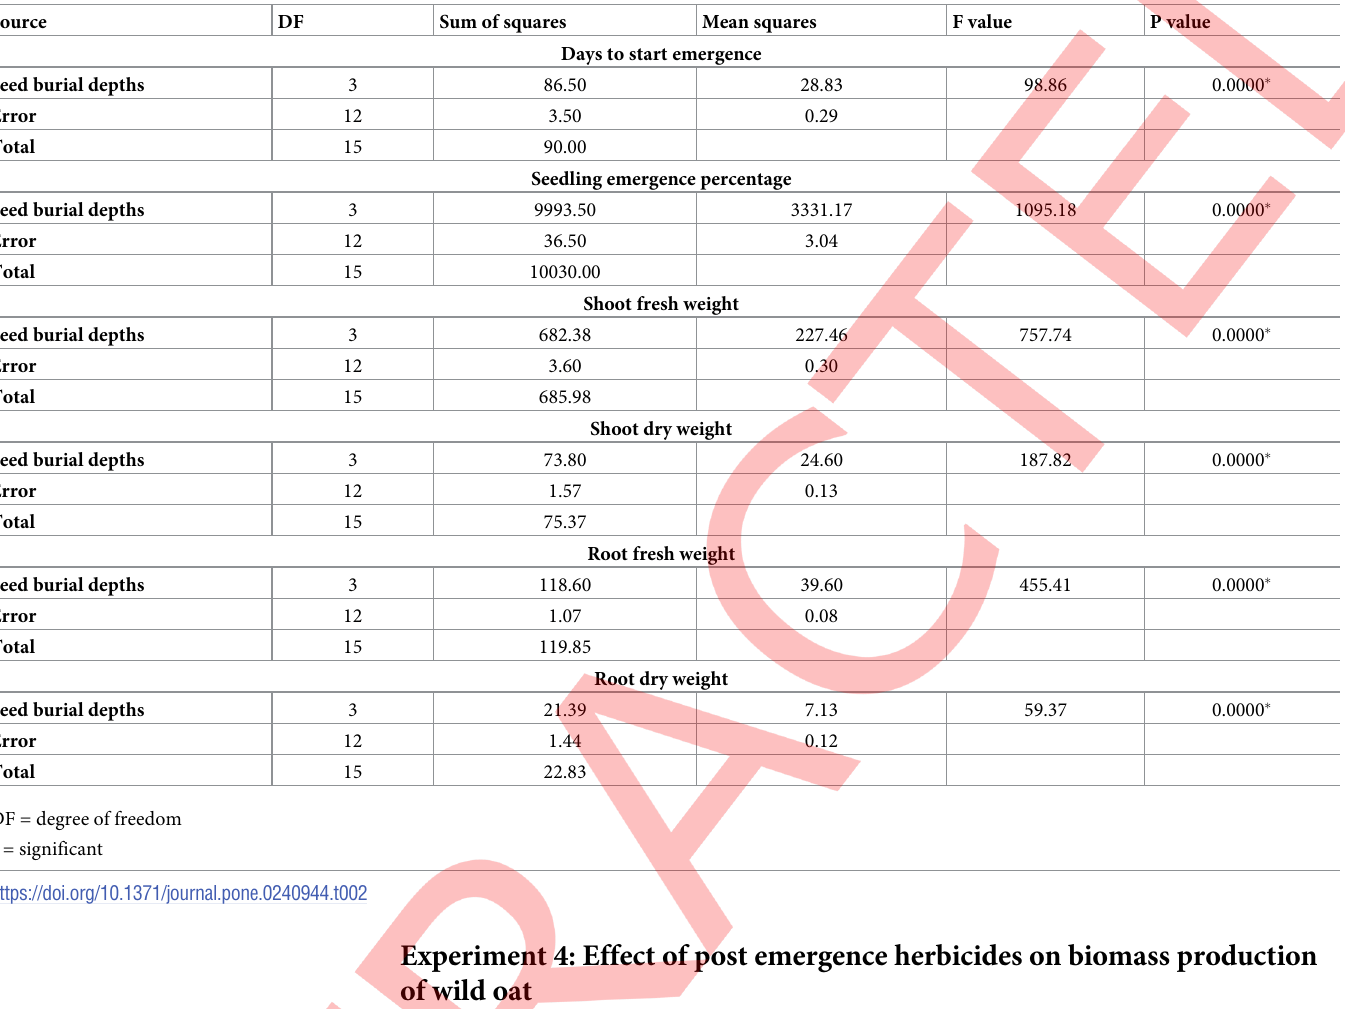
Experiment 4: Effect of post emergence herbicides on biomass production of wild oat